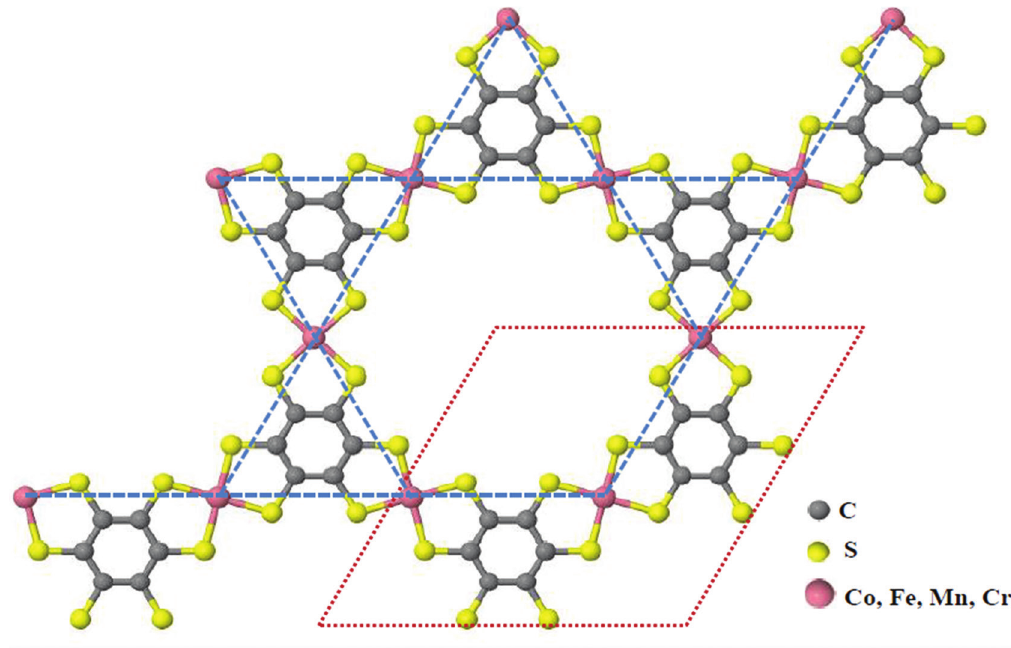
Figure 2: 2 × 2 supercell of 2D CoBHT(CO) lattice.